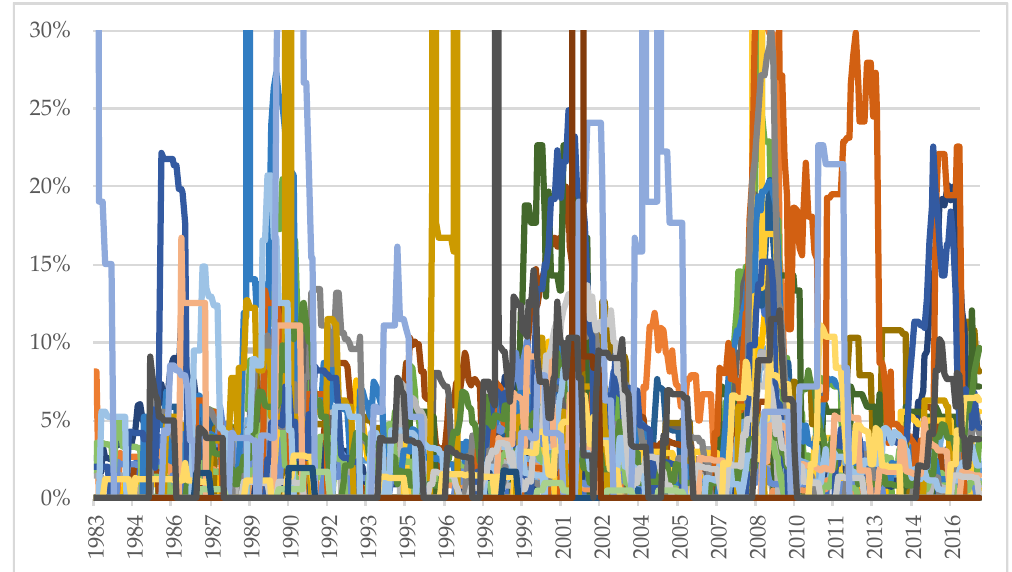
Figure 2. Corporate default rates across different sectors. Note that the exhibit presents sectoral default rates for 33 non-financial corporate sectors; each sector is shown in a different colour. The vertical axis was deliberately limited to 50% to illustrate volatility within and across sectors relative to lower default rates in some time periods. Source: Moody’s.